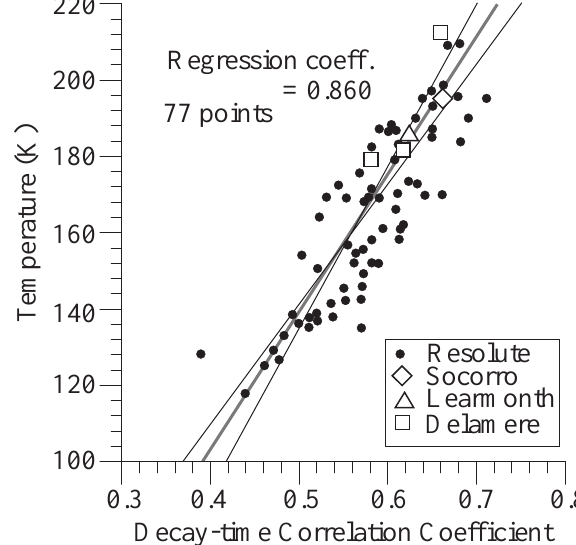
Fig. 2. Plot of the decay-time correlation coefficient (deduced from graphs like Fig. 1c) as a function of true temperature, for vari- ous sites in both the Northern and Southern Hemisphere. Best-fit lines show the regression of the ordinate on the abscissa (shallowest slope), the regression of the abscissa on the ordinate (steepest line) and the best-fit line assuming equal relative errors. The regression coefficient is